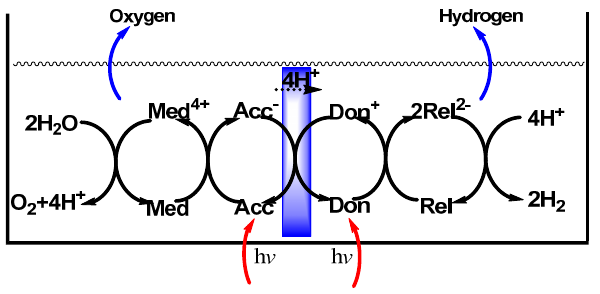
Figure 1. Scheme of the sensitized photosplitting of water through the use of two photochemical reactions working in series: Don = donor dye molecule; Rel = electron relay species; Acc = acceptor dye molecule; Med = electron mediator species. The membrane is permeable to both electrons and H + ions.